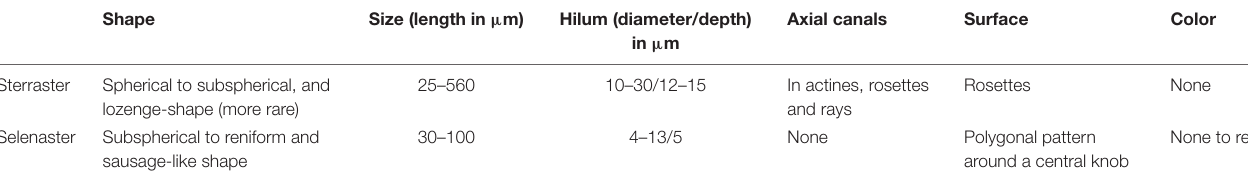
TABLE 2 | Morphological comparison of Recent sterrasters and